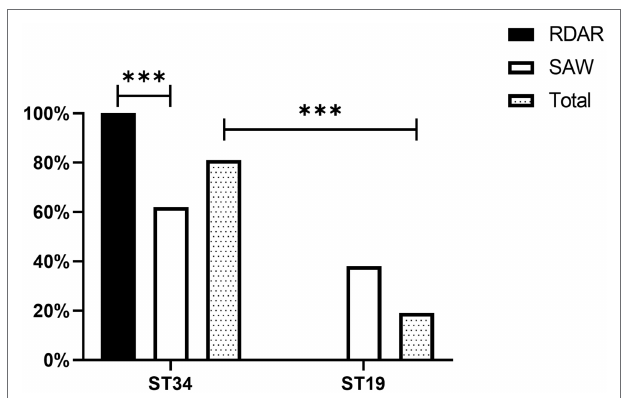
FIGURE 2 | Multi-locus sequence typing of colonies of different phenotypes ( *** p < 0.001).